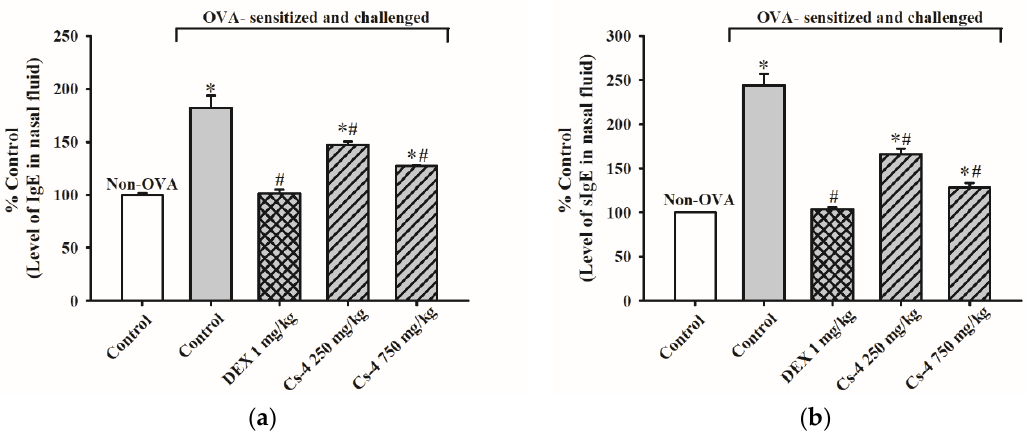
Figure 2. The effect of Cs-4 on ( a ) the levels of immunoglobulin E (IgE) and ( b ) OVA-specific IgE in the lavage nasal fluid (NFL) of OVA-sensitized and challenged mice. Each bar represents the mean ± S.E.M., with n = 5. * Significantly different from the non-OVA control group. # Significantly different from the OVA-sensitized and challenged control group.